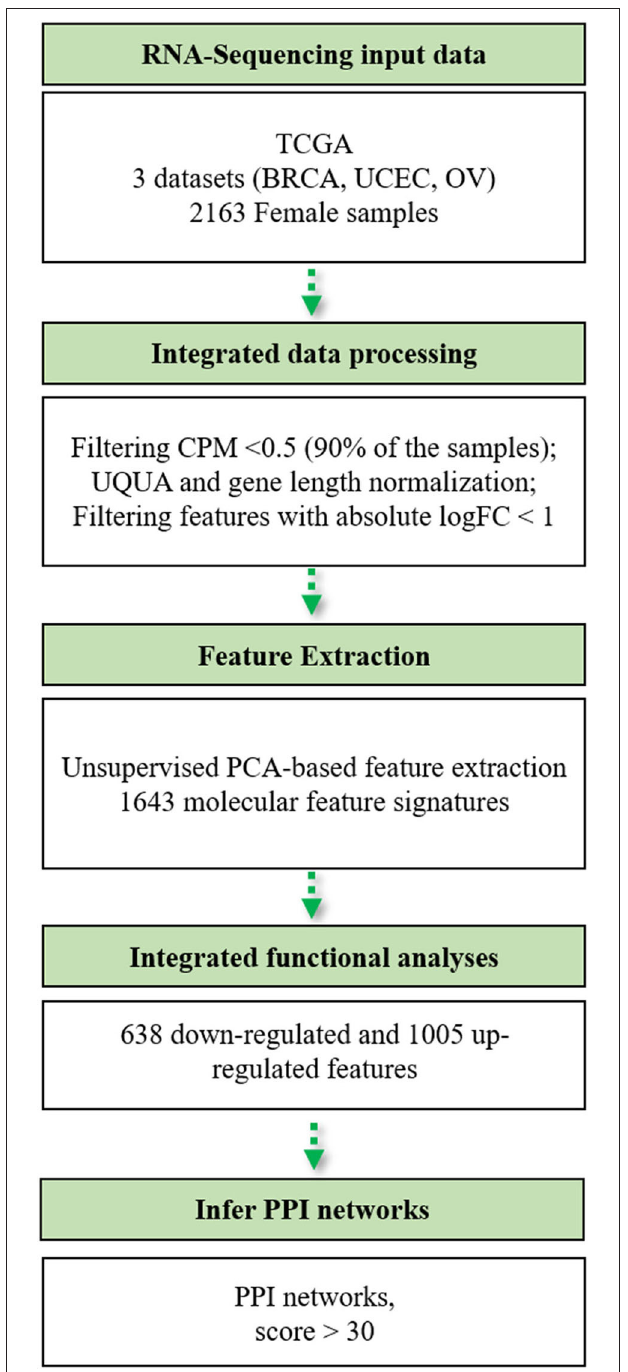
FIGURE 1 | Flowchart of the bioinformatics pipeline used in this study. TCGA, The Cancer Genome Atlas; BRCA, breast cancer; UCEC, uterine cervix endometrial cancer; OV, ovarian cancer; CPM, counts per million; UQUA, upper quartile normalization method.